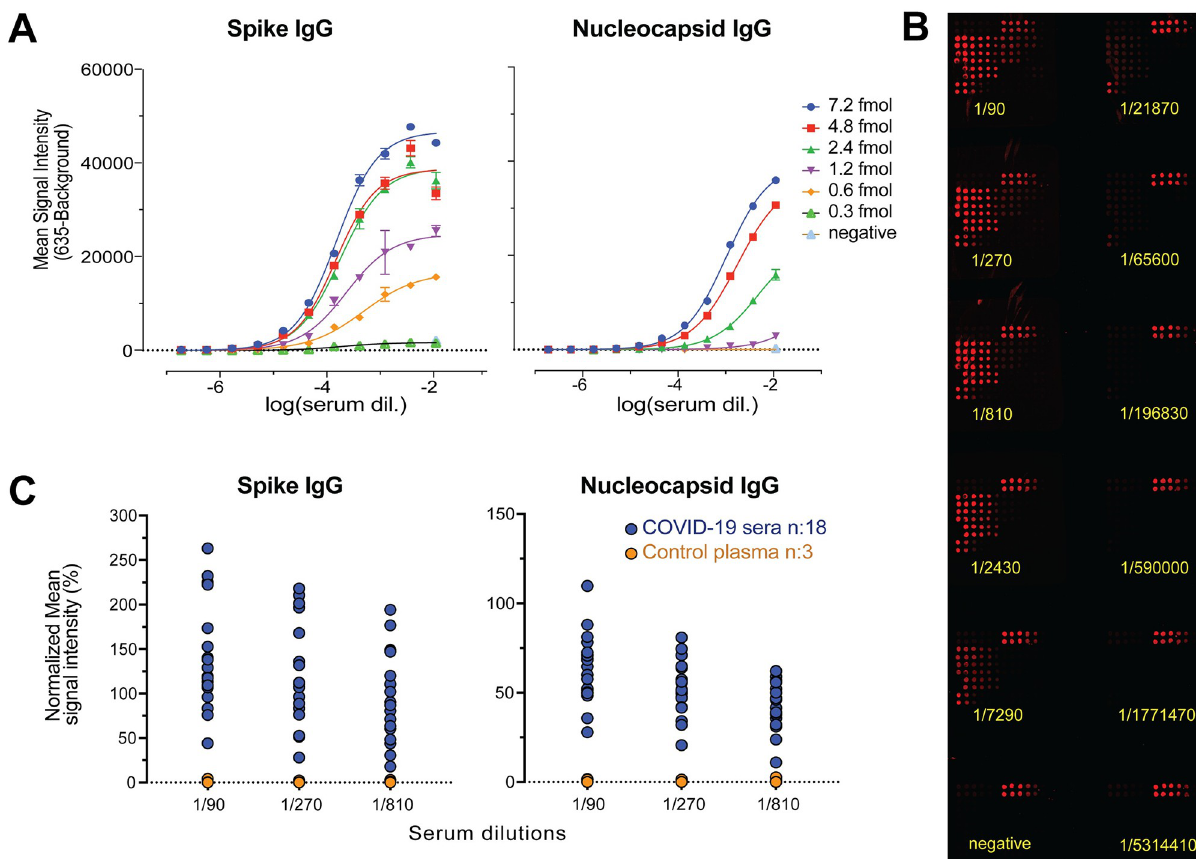
Fig 2. Serial dilution test to identify a single dilution that gives reliable detection for multiple sera/plasma samples. (A) Spike and nucleocapsid IgG levels are shown for single serum sample at 11 serial dilutions against six protein concentrations. Mean values ± SD are shown for duplicates. (B) Representative image of protein microarray printed with 12 identical subarrays that was used for IgG detection in a single sample with three-fold serial dilutions. (C) Spike and nucleocapsid IgG levels are shown for multiple samples (n:21) with three highest serial dilutions. The results for five antigen concentrations (7.2, 4.8, 2.4, 1.2, 0.6 fmol) are normalized relative to corresponding concentration of IgG isotype controls, and averaged. The mean values are calculated for the replicates of target antigen for each